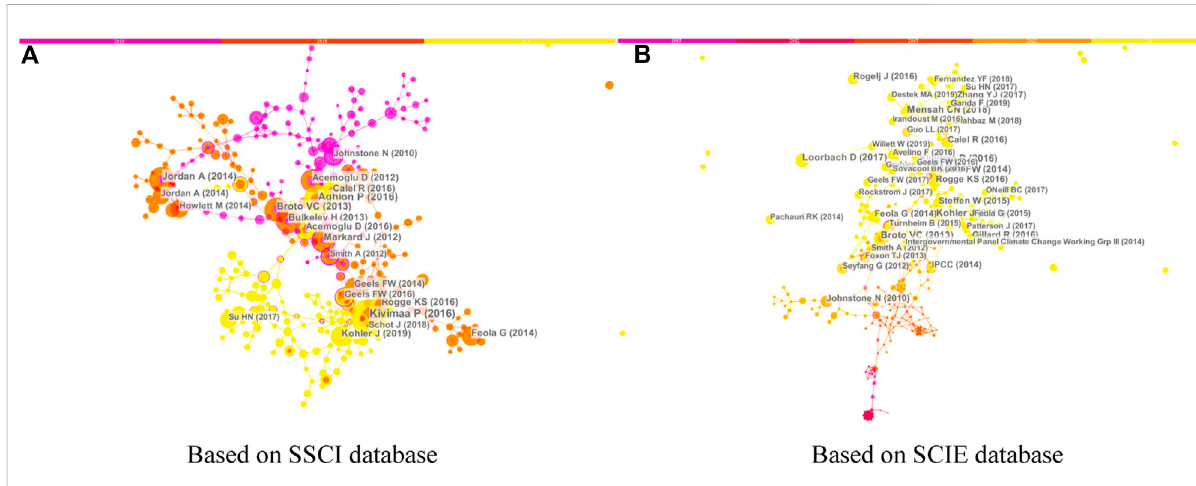
FIGURE 6 Map of the document co-citation network of climate innovation research. (A) refers to the SSCI database and (B) refers to the SCI